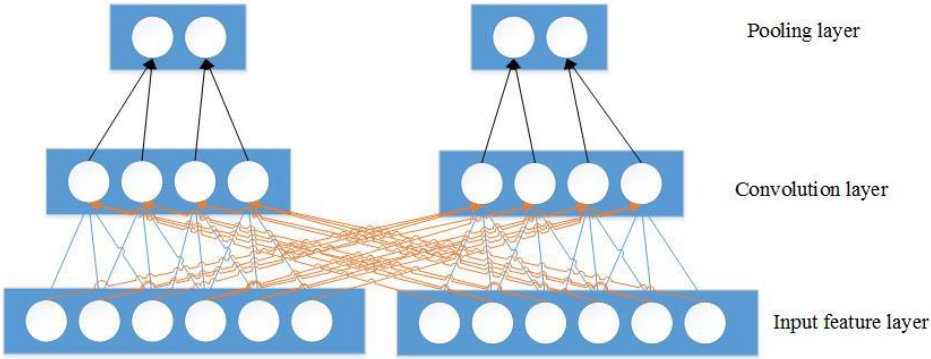
Figure 1. Schematic diagram of the convolution structure.